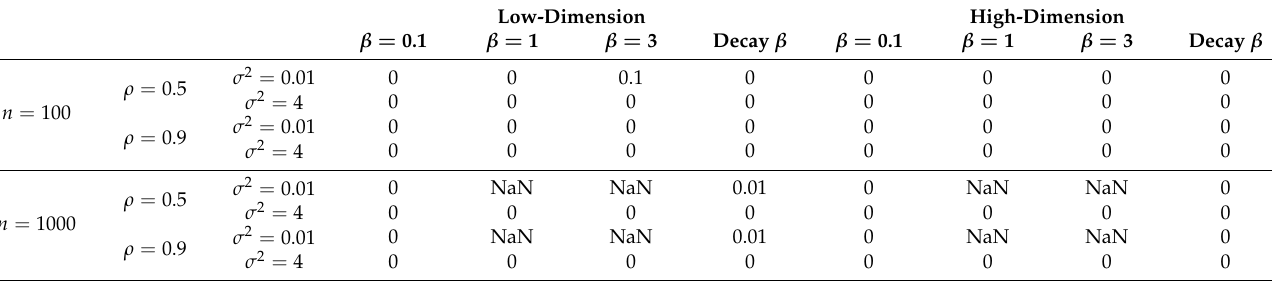
Table A8. Variable selection: P c ( λ 1 se ) − P c ( λ min ) : constant correlation.